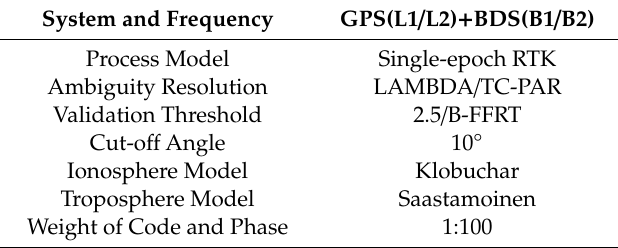
Table 3. Basic processing